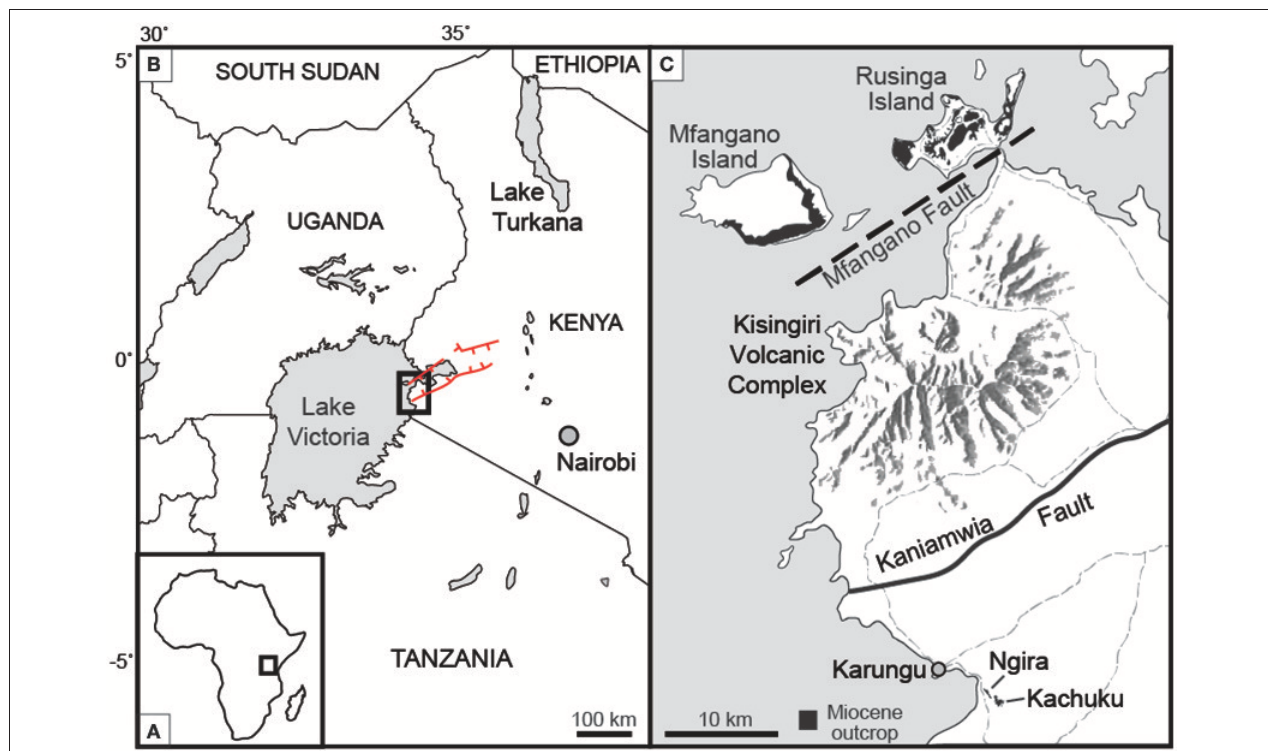
FIGURE 1 | Location of study site (A) on the African continent, and (B) within western Kenya. Red lines indicate the boundary faults of the Nyanza rift. (C) Ngira and Kachucku together comprise the Karungu outcrop areas, located roughly 50km south of Rusinga and Mfangano Islands. Light gray dashed lines are roads. Modified after Bestland et al. (1995), Geraads et al. (2016), and Driese et al.